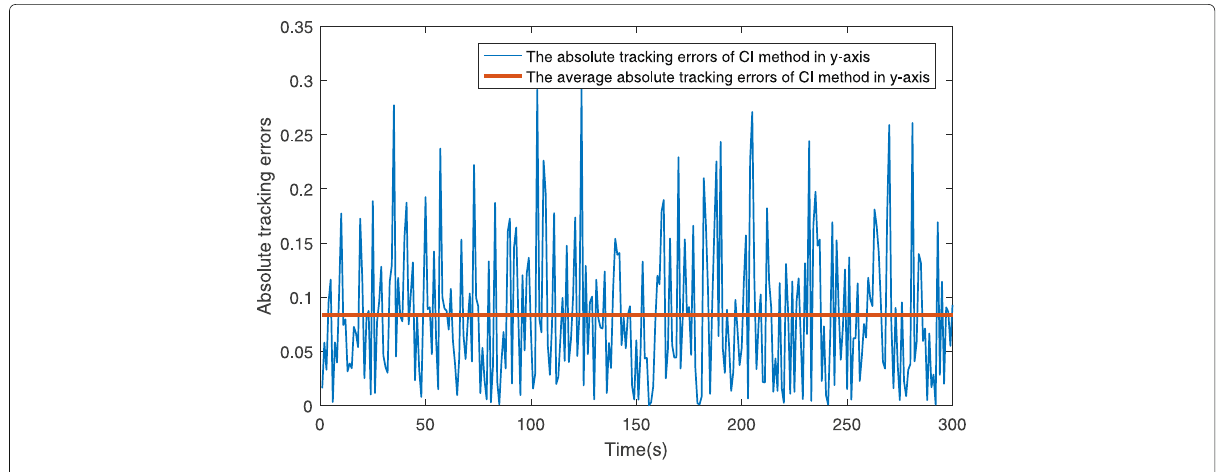
Fig. 3 The absolute tracking errors of CI method in y -axis with a i = 8